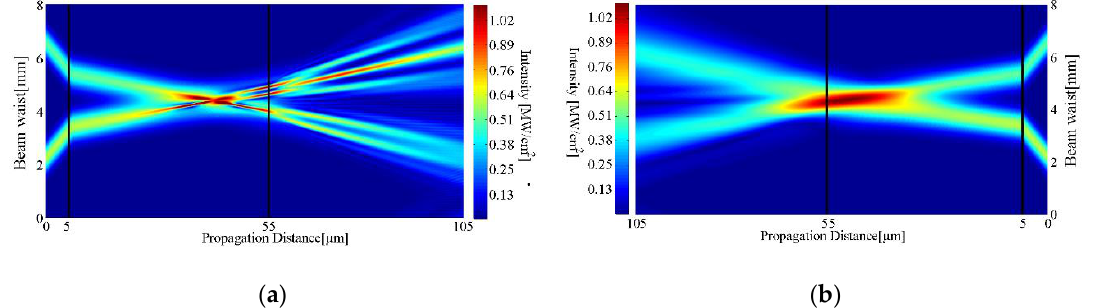
Figure 8. Numerical results of the propagation of a degenerated two-wave mixing in the studied bilayer sample at 532 nm wavelength: ( a ) forward direction; the beams initially interacts in the MWCNT film and then in the Pt-MWCNT; ( b ) backward direction; the beams initially interacts in the Pt-MWCNT film and then in the MWCNT.